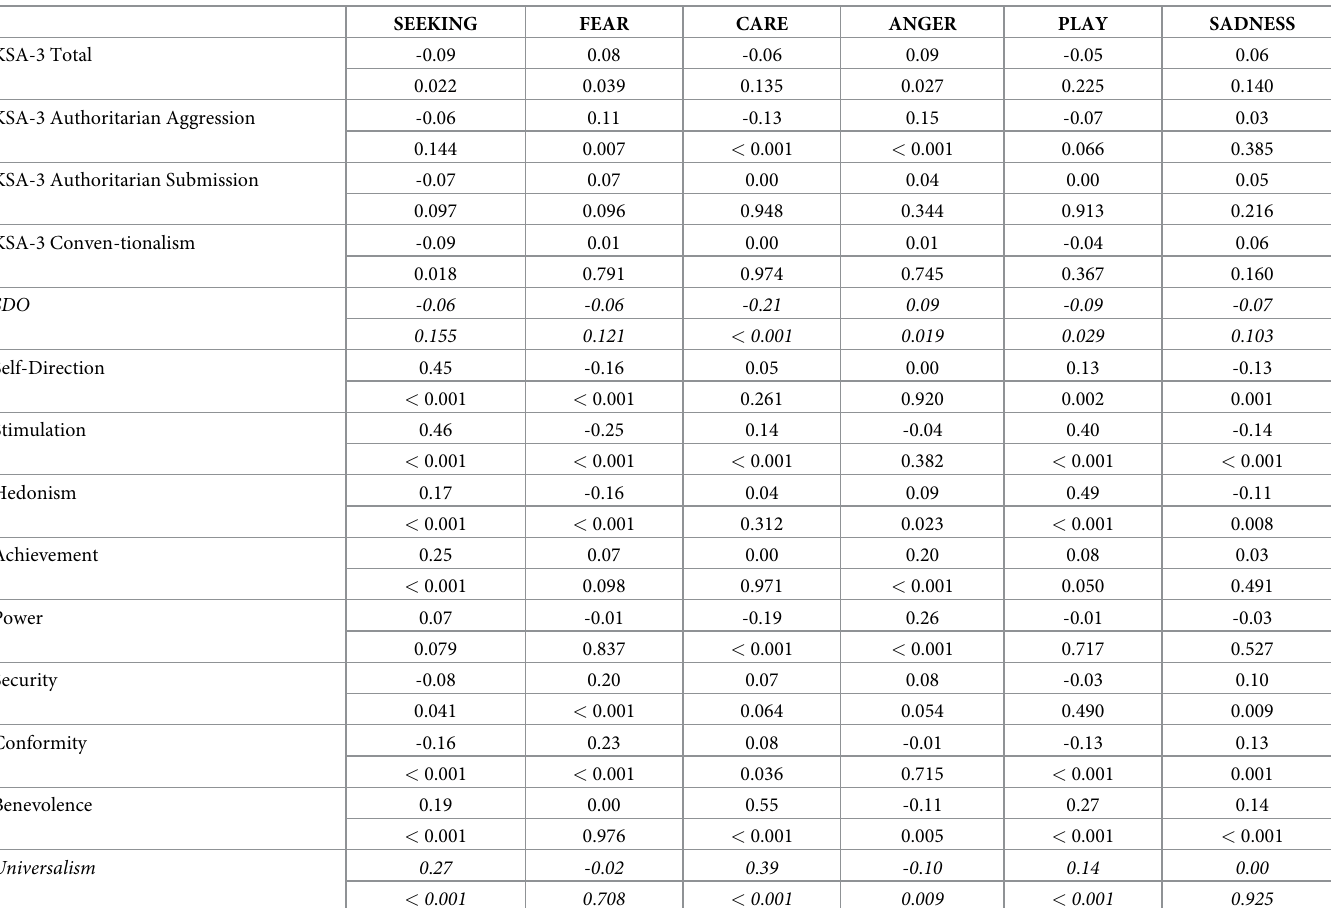
Table 2. Zero-order correlations of the ANPS with the KSA-3, SDO, and PVQ